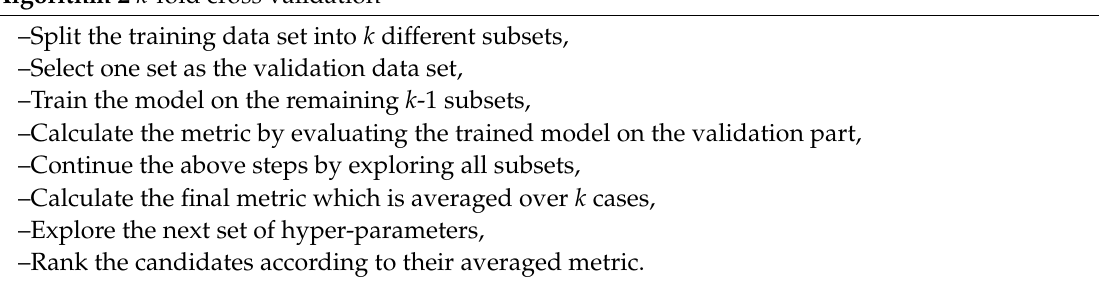
Algorithm 2 k -fold cross